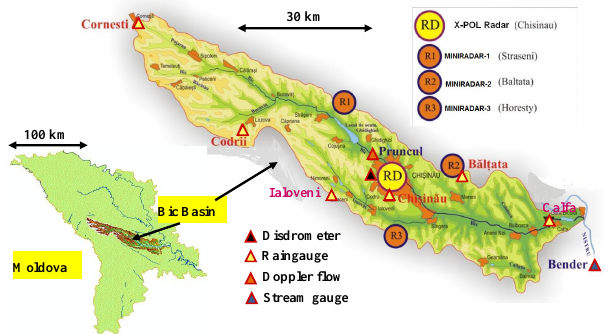
Figure 1. The Bic basin location in Moldova and detail of the Bic river basin showing Fig. 1. The Bic basin location in Moldova and detail of the Bic